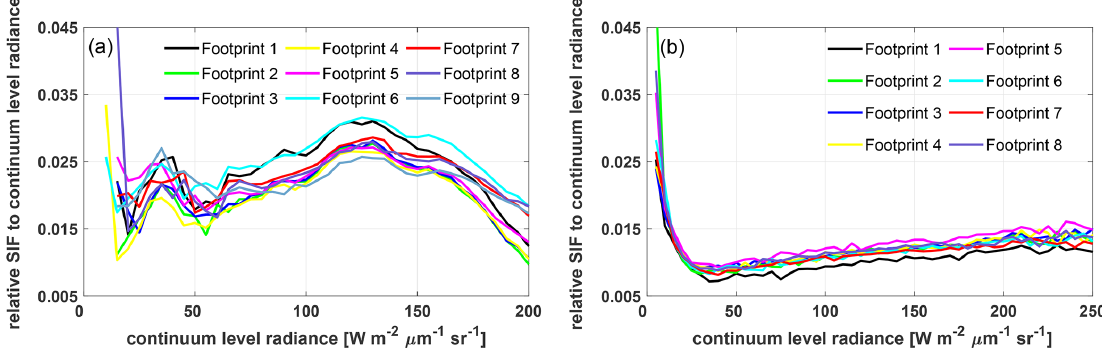
Figure 2. Variations in the bias correction curves of continuum level radiance from (a) TanSat on 7 July 2017 and (b) Orbiting Carbon Observatory-2 (OCO-2) on 16 June 2017. The different colors in the legend present different footprints of the satellite frame. Table 1. Summary of the relationship between the IAPCAS OCO-2 and IMAP-DOAS OCO-2 SIF products in the 757nm micro-window. Date Number of Slope Intercept R 2 RMSE (yyyy/mm) soundings 2017/03 1097277